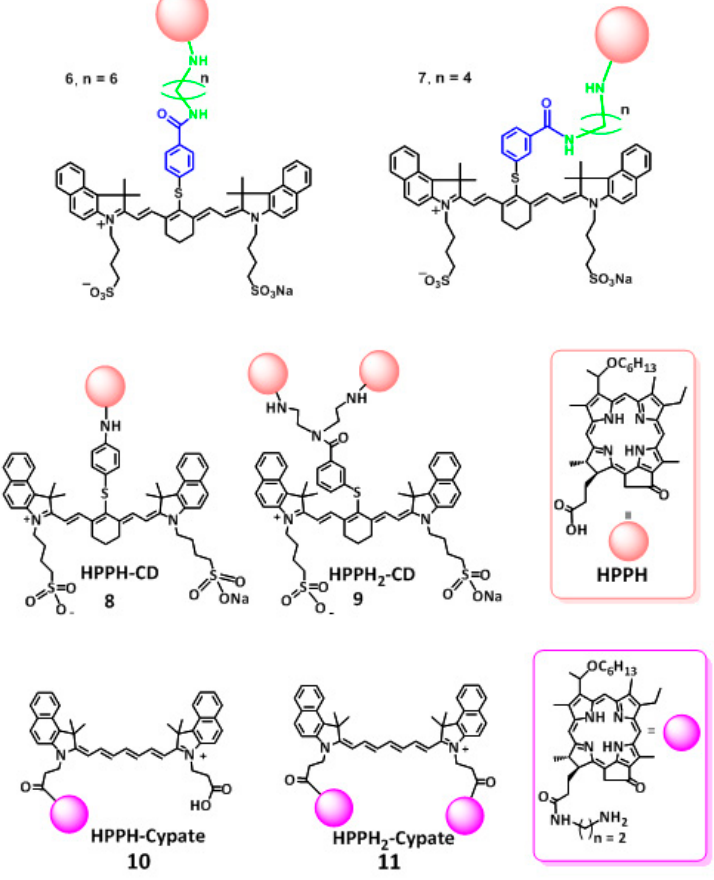
Figure 2. Structures of the conjugates 6 – 11 used for the study.